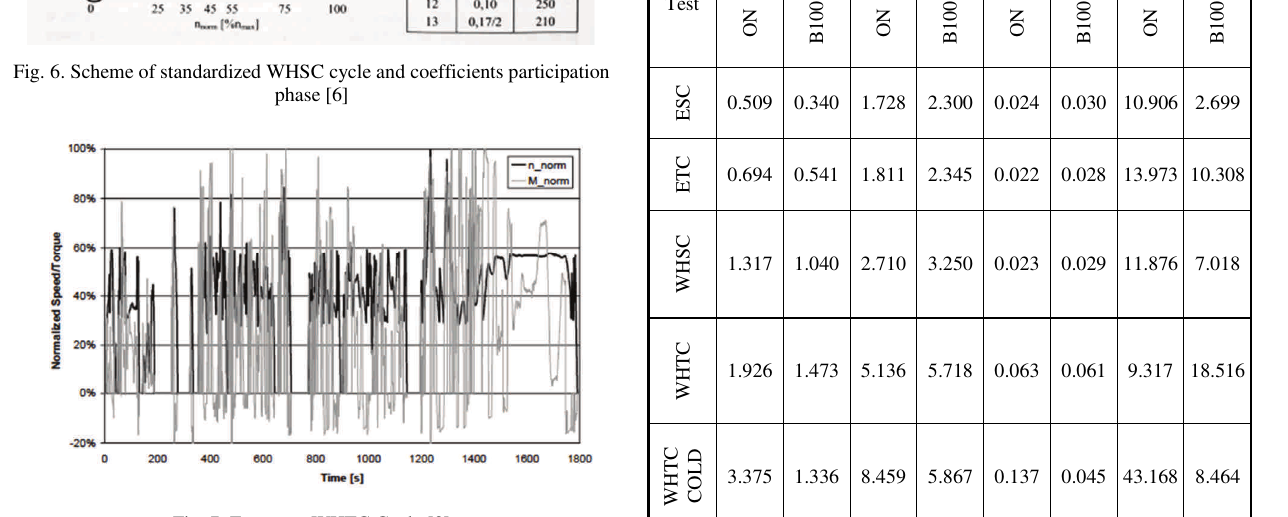
Fig. 7. European WHTC Cycle [8]